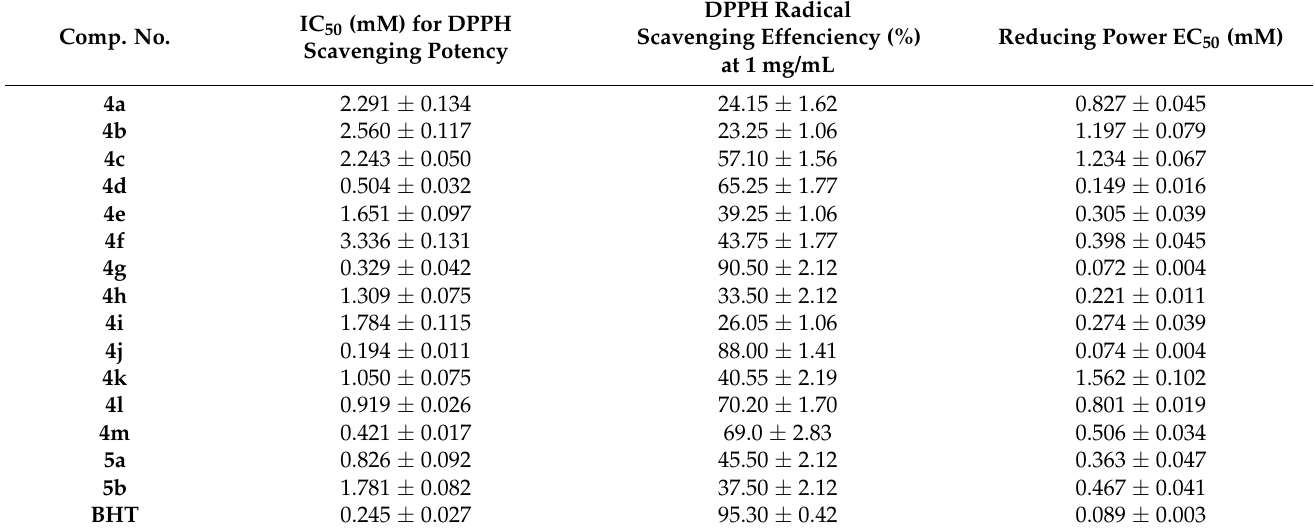
Table 1. Antioxidant activities of the studied 4 H -pyran and 4 H -pyrano[2,3- c ]pyrazole derivatives as determined by calculation of IC 50 (mM) and EC 50 (mM) values. Experiments were performed in triplicate and are reported as the means ± standard